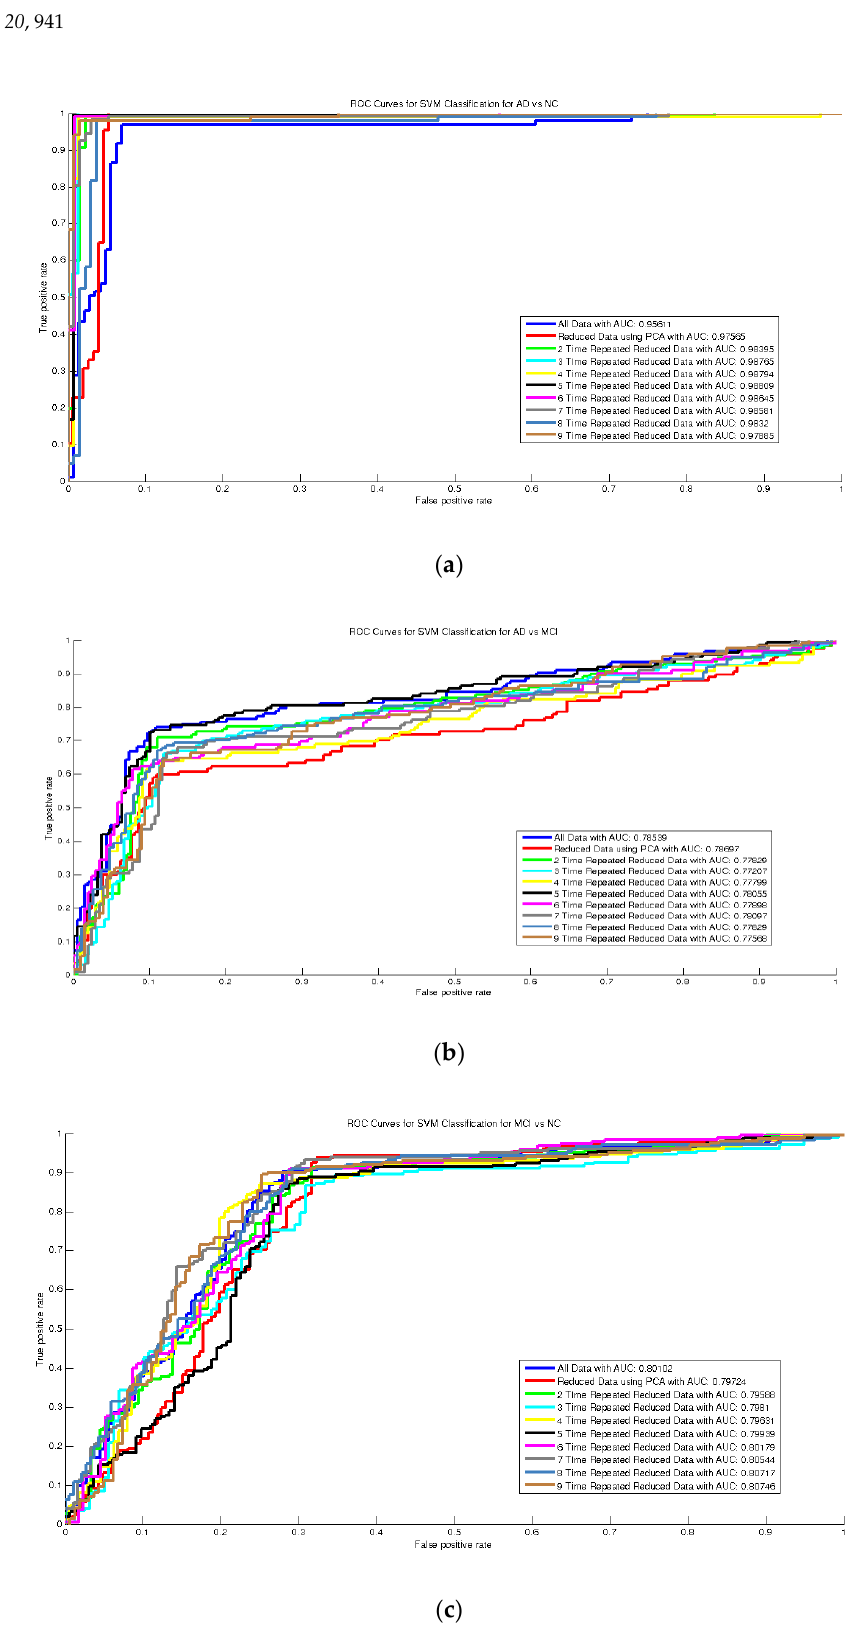
Figure 7. Receiver operating characteristic (ROC) curves for recognition of: ( a ) AD vs. NC, ( b ) AD vs. MCI, and ( c ) MCI vs. NC, of all features and 25 PCA elements for 1 – 9× repeated feature reduction.